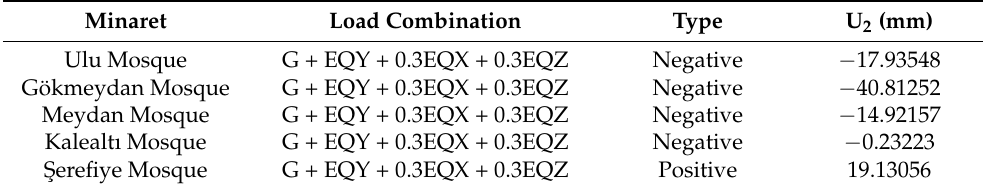
Table 10. Maximum displacements of Five Minarets in U y direction.